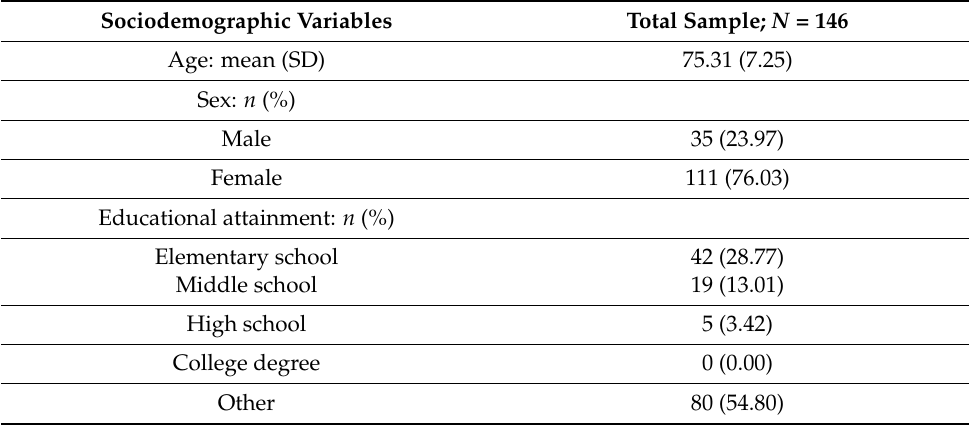
Table 1. Demographic characteristics of the sample ( N = 146).